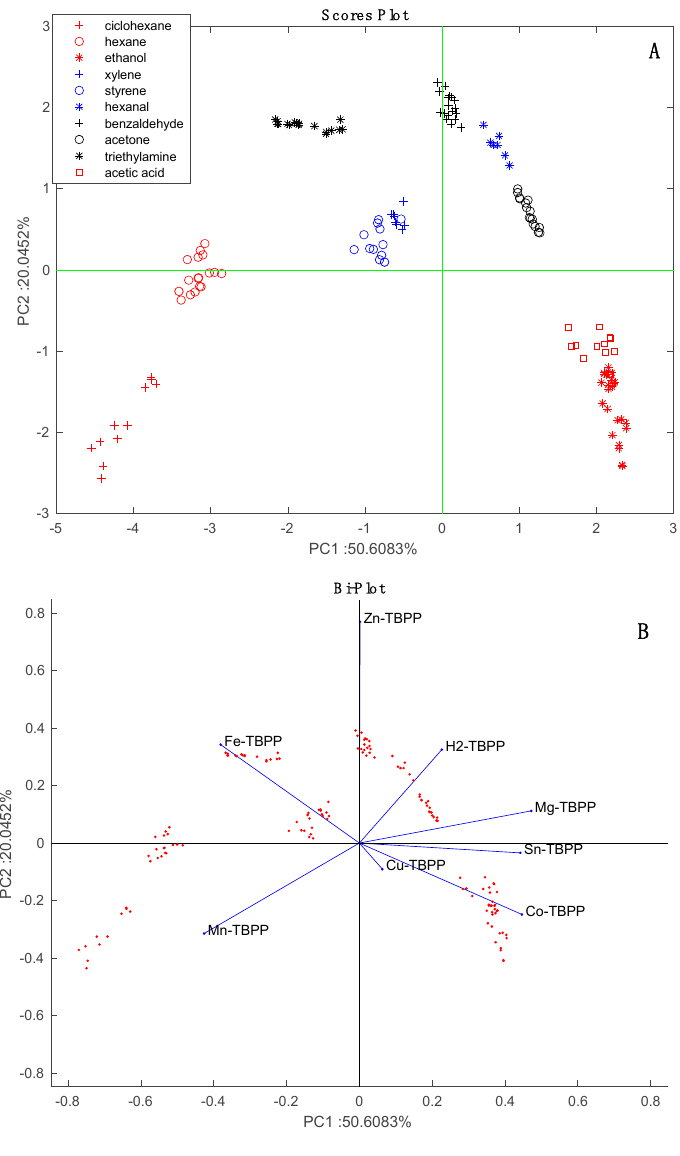
Figure 2. Principal Component Analysis (PCA) of characterization data. ( A ) Scores plot, ( B ) bi-plot which shows the loadings of the sensors.